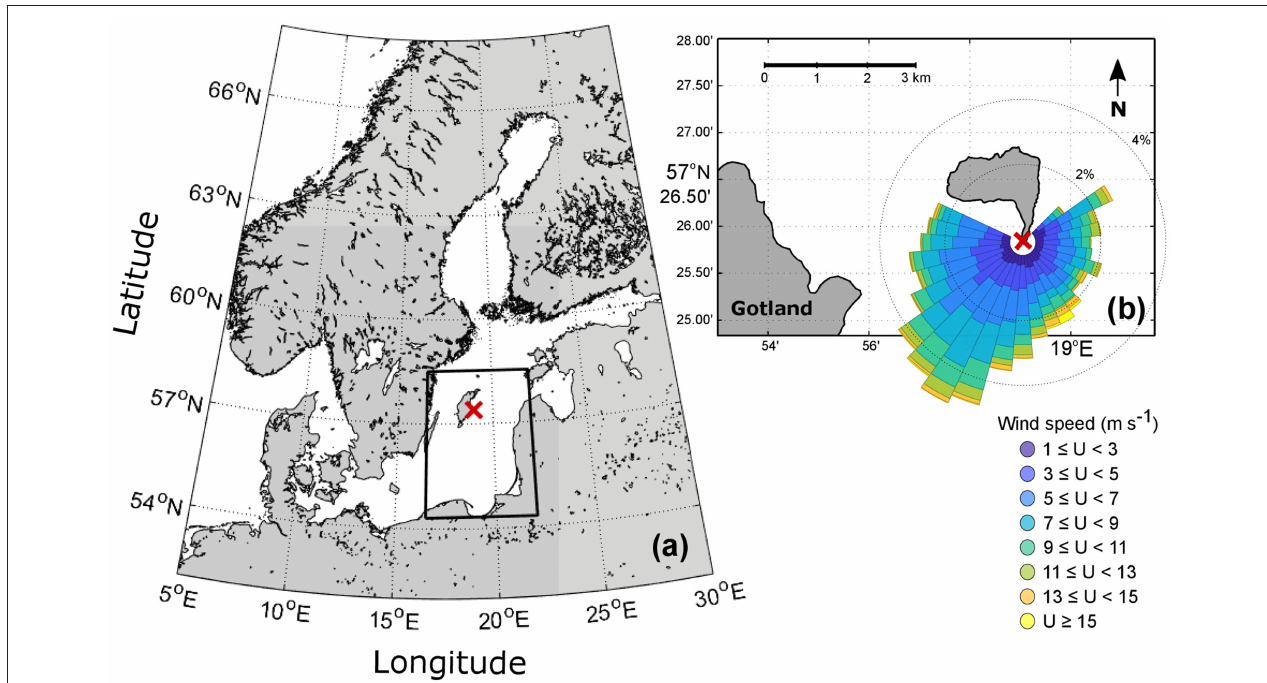
FIGURE 1 | (a) Map of the Baltic Sea. The red mark in the central Baltic Sea indicates the location of the Östergarnsholm station; the Gotland Basin is the area within the black rectangle. (b) Location of Östergarnsholm island situated ca 4 km off from the Gotland island. The red mark indicates the location of the tower; the colors are the wind rose representing the distribution of wind speed and wind direction at the Östergarnsholm station.